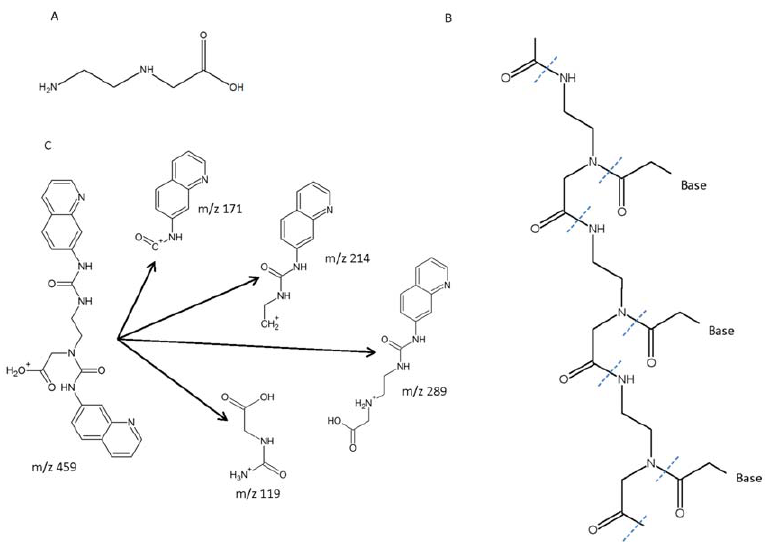
Figure 1. AEG [N-( 2 -aminoethyl)glycine] is a small molecule which when polymerized can form a peptide nucleic acid backbone. A, The AEG monomer. B, its proposed role as a peptide nucleic acid showing three AEG molecules each connected to a base by an acetyl linkage. C, Predicted fragmentation pattern of AQC derivatized AEG ( m/z 459) following collision-induced dissociation to produce daughter ions of m/z 171, 214, 289 and 119. Predicted structures were produced using High Chem Mass Frontier 5.1 software (High Chem Ltd., Slovak Republic).